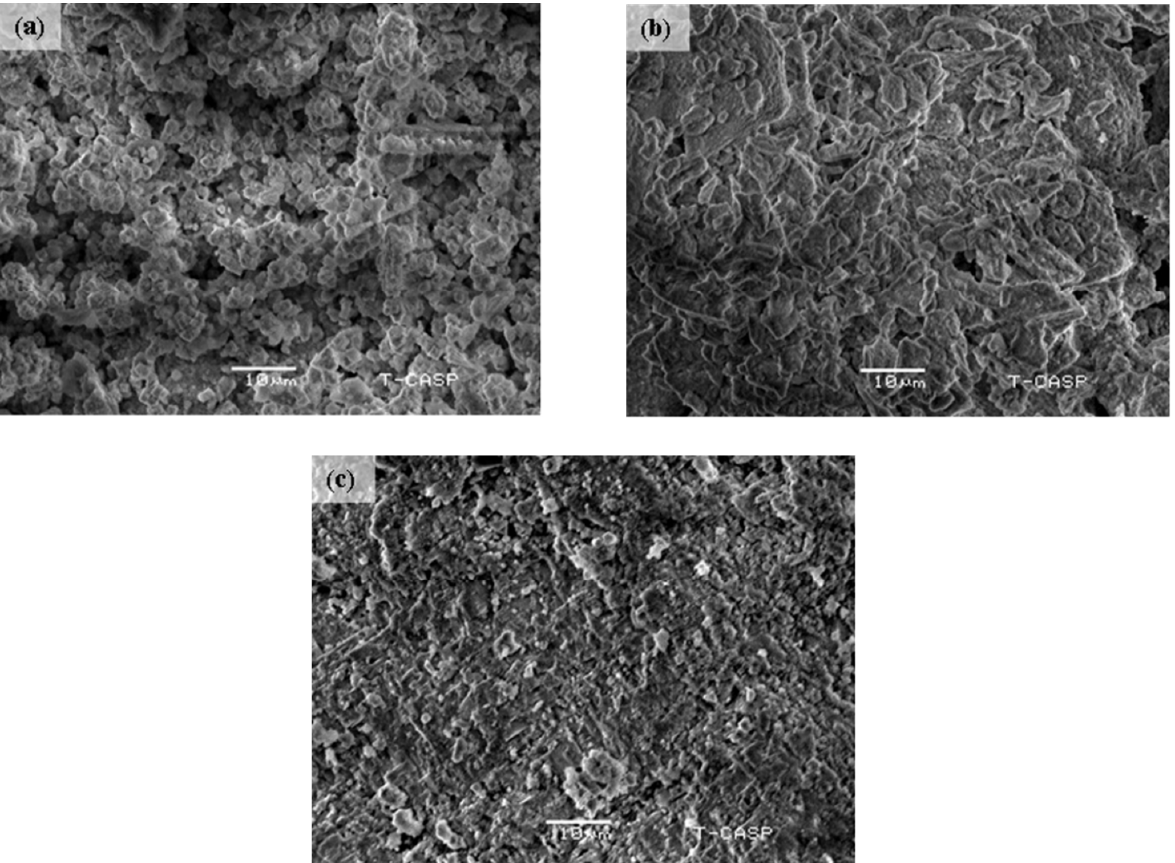
Figure 2. Micrographs of sintered BaCe 0.2 Zr 0.6 Y 0.2 O 3 - δ electrolyte: ( a ) 900 °C, ( b ) 1000 °C, and ( c ) 1100 °C .